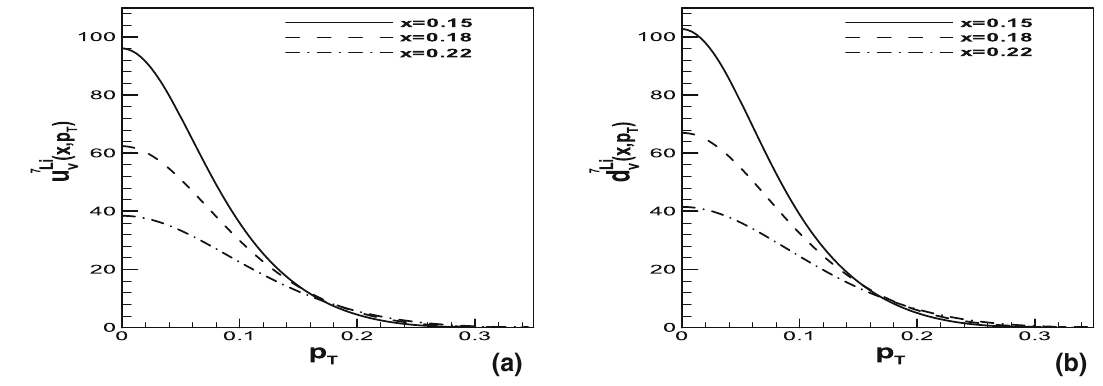
Fig. 6 The TMD valence a u and b d quark distributions of 7 Li with respect to p T at x = 0 . 15 , 0 . 18 and 0 .